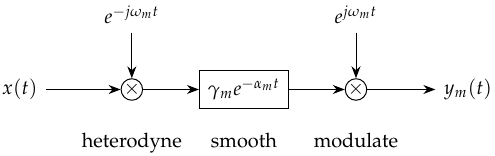
Figure 4. Mode response implementation. The mode response may be implemented as a cascade of heterodyning, smoothing, and modulation